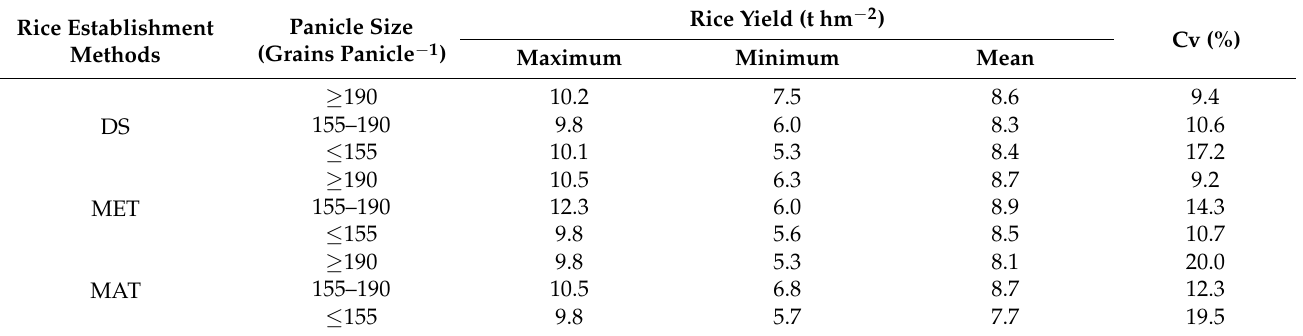
Table 4. Variations of rice grain yield for hybrid indica rice (HIR) with different panicle sizes (grain number per panicle) in different establishment methods. DS, MET, and MAT represent directed seeded method, mechanical transplanted method, and manual transplanted method,